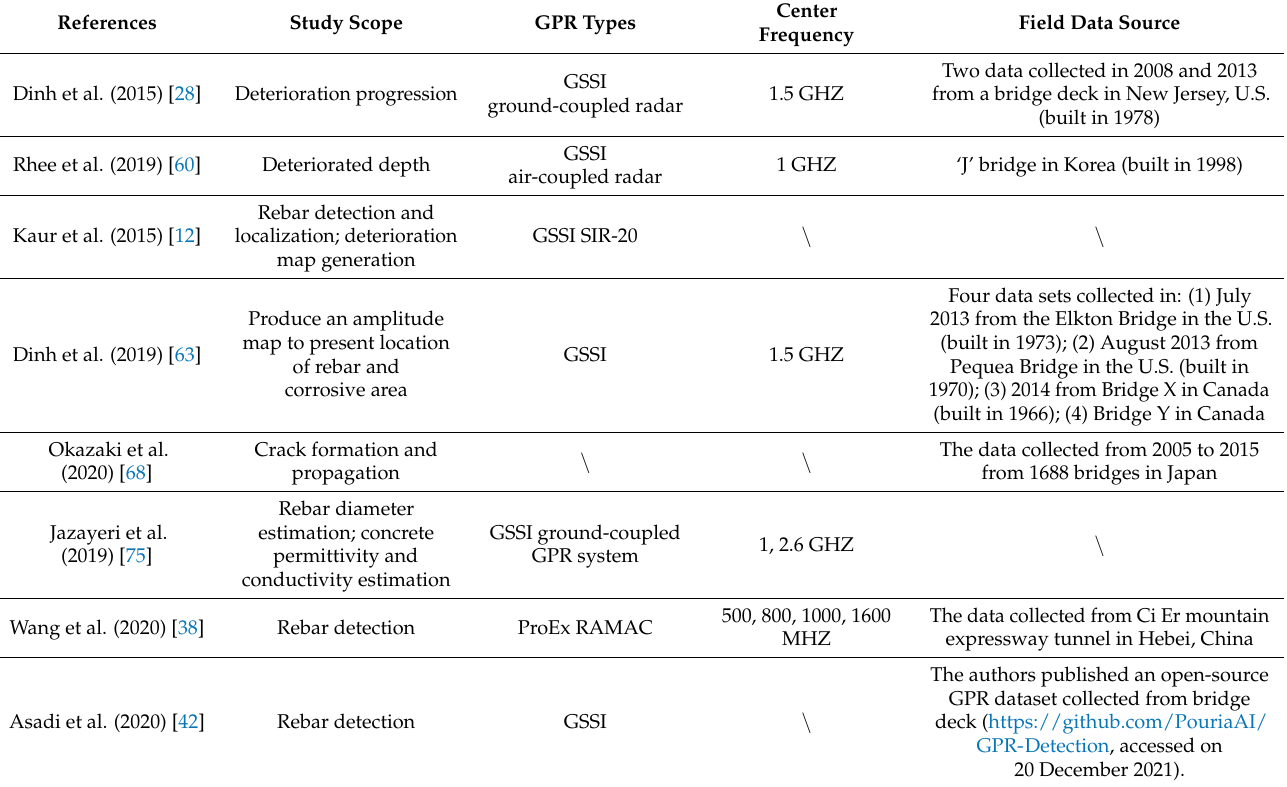
Figure 5. Examples of field application scenarios. ( a ) concrete bridge rebar scanning; ( b ) tunnel rebar mesh scanning. Table 1. Some examples of the latest GPR works in bridge applications.